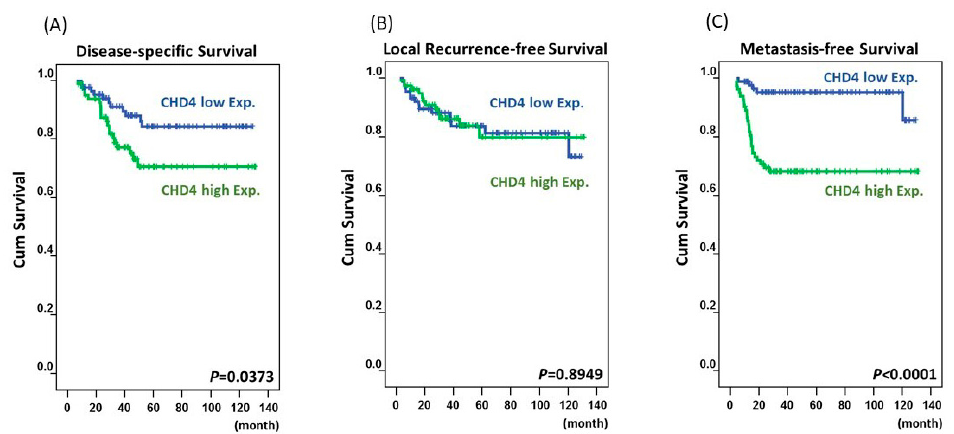
Figure 3. Kaplan-Meier survival curves of patients with varying CHD4 expression. High expression of CHD4 predicted inferior disease-specific survival ( p = 0373) ( A ), but there was no significant difference in metastasis-free survival ( p = 8949) ( B ). The CHD4 expression also demonstrated a significant prognostic impact on metastasis-free survival ( p < 0001) ( C ). Table 3. Multivariate analysis.